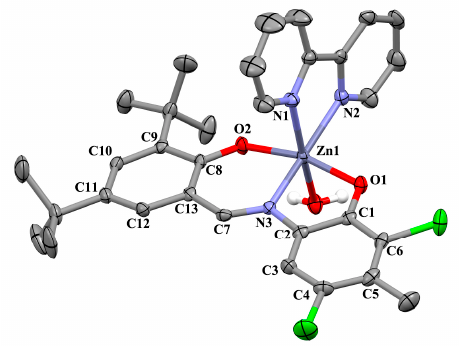
Figure 1. The molecular structure of 4 ∙ H 2 O in crystals 4 ∙ H 2 O ∙ CH 3 CN. The hydrogen atoms except for water are omitted for clarity. The ellipsoids of 50% probability.